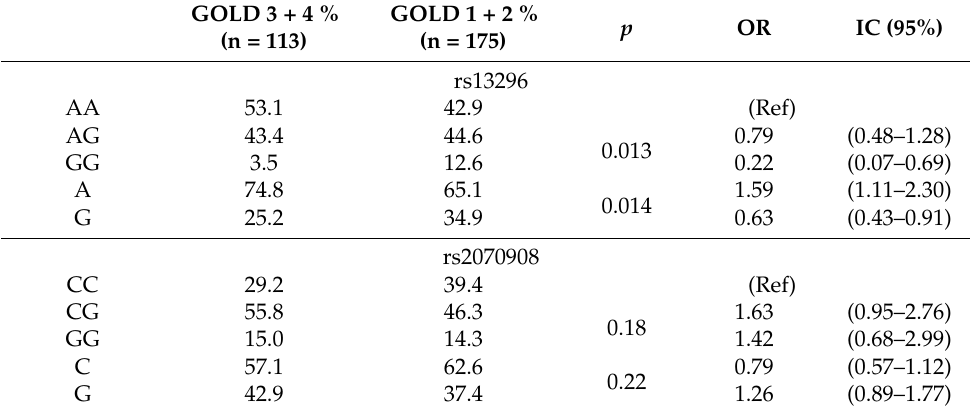
Table 8. Allele and genotype comparison for severity in COPD-TS group.